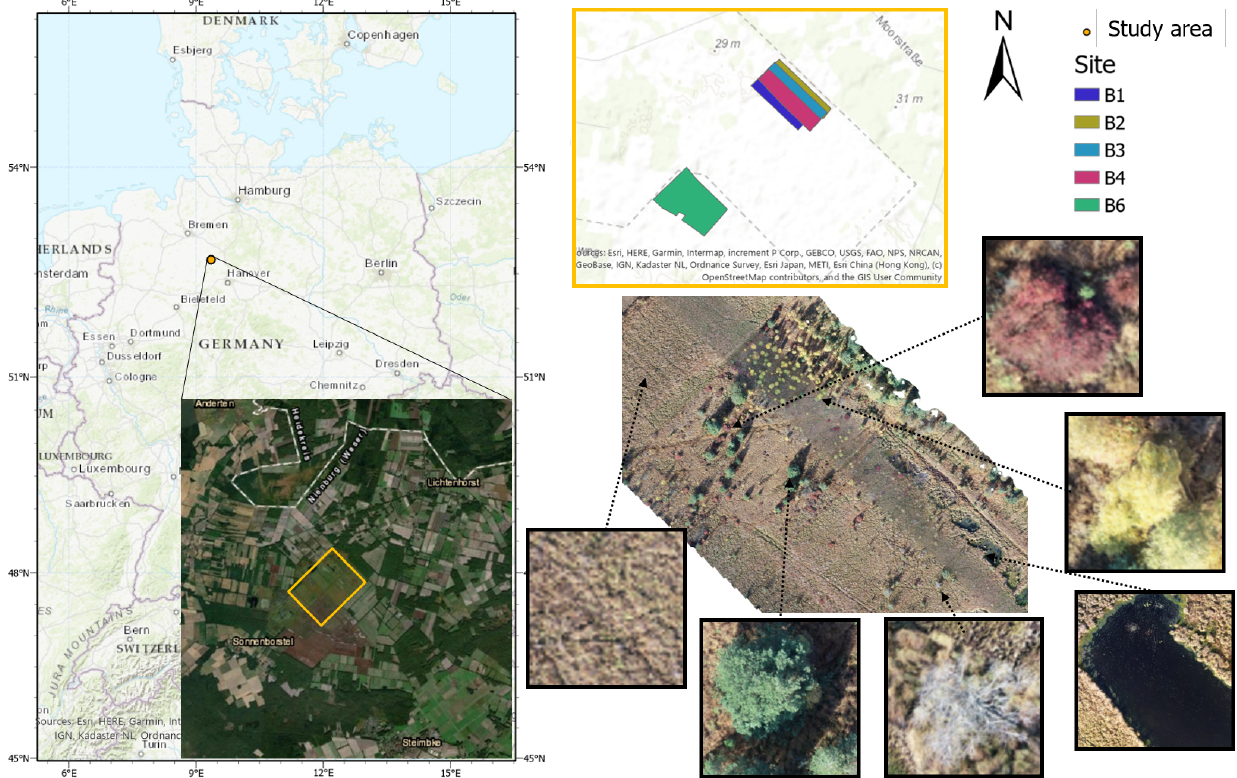
Figure 1. Location of the study area in the north of Germany. In the upper right part of the figure, the study sites are marked with different colours. The bottom right part an example orthomosaic is shown with detail of the different